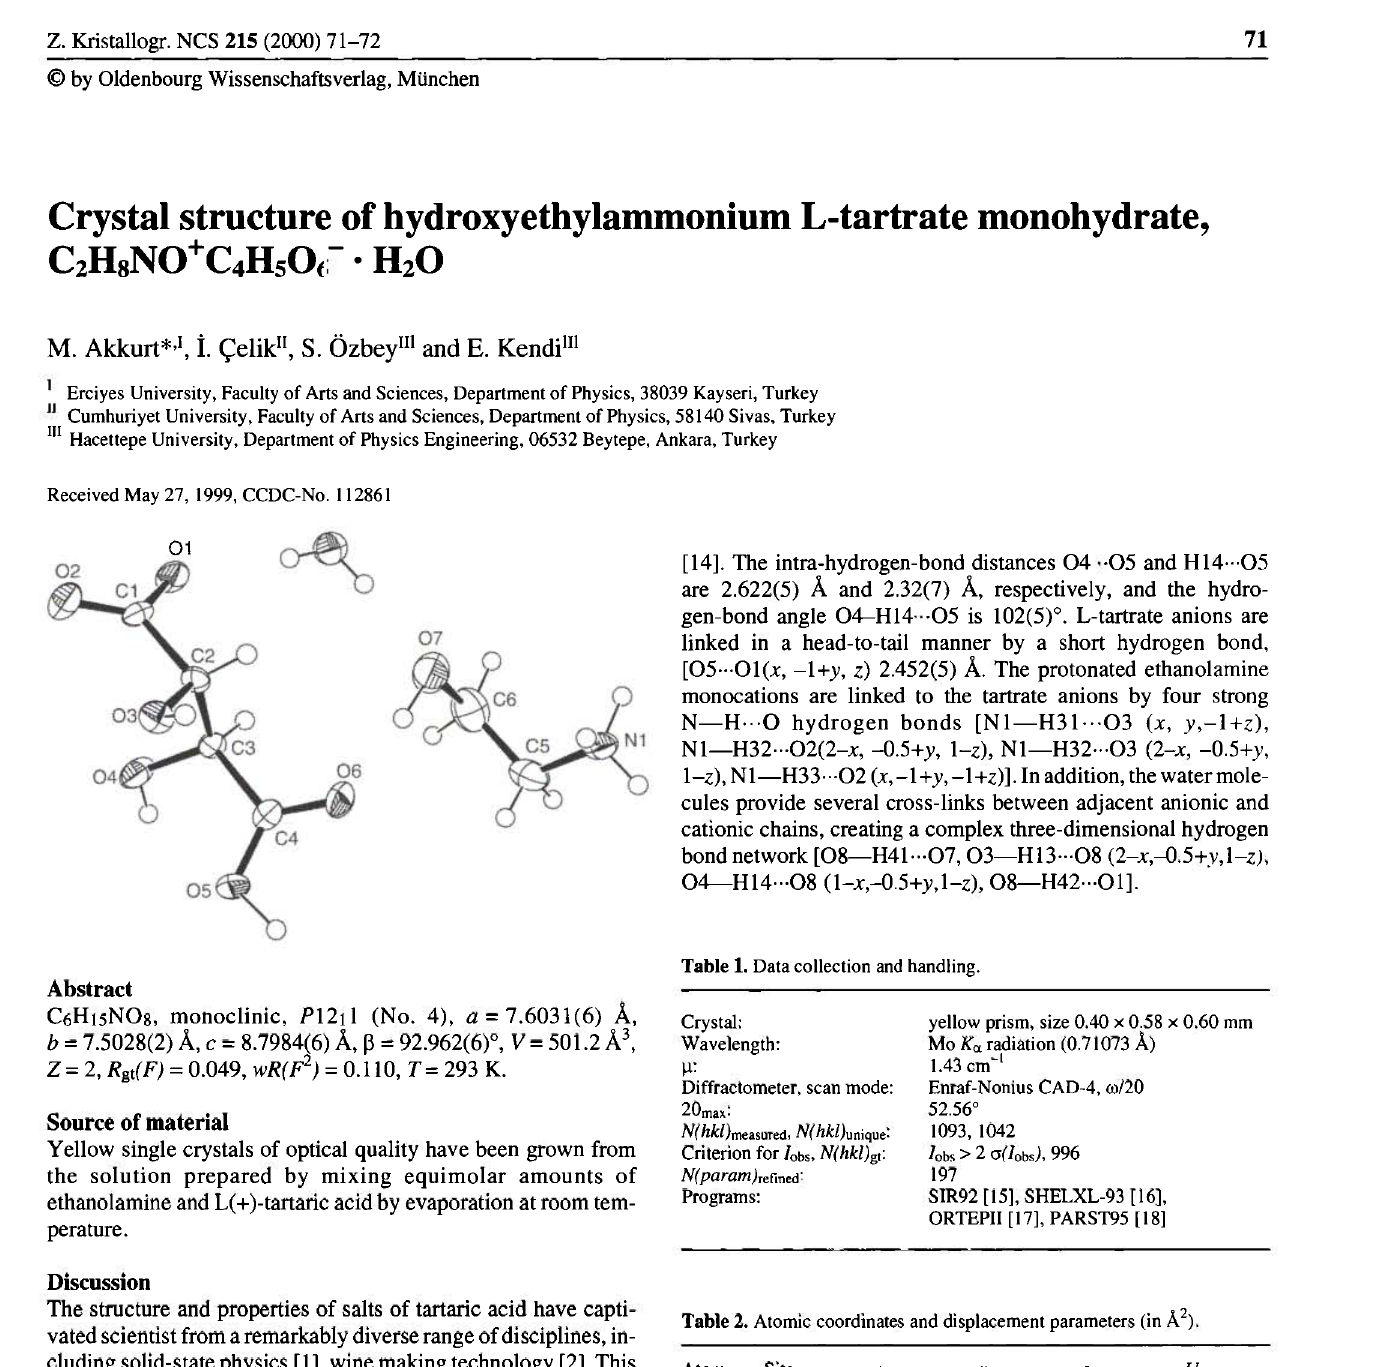
Table 2. Atomic coordinates and displacement parameters (in Ä 2